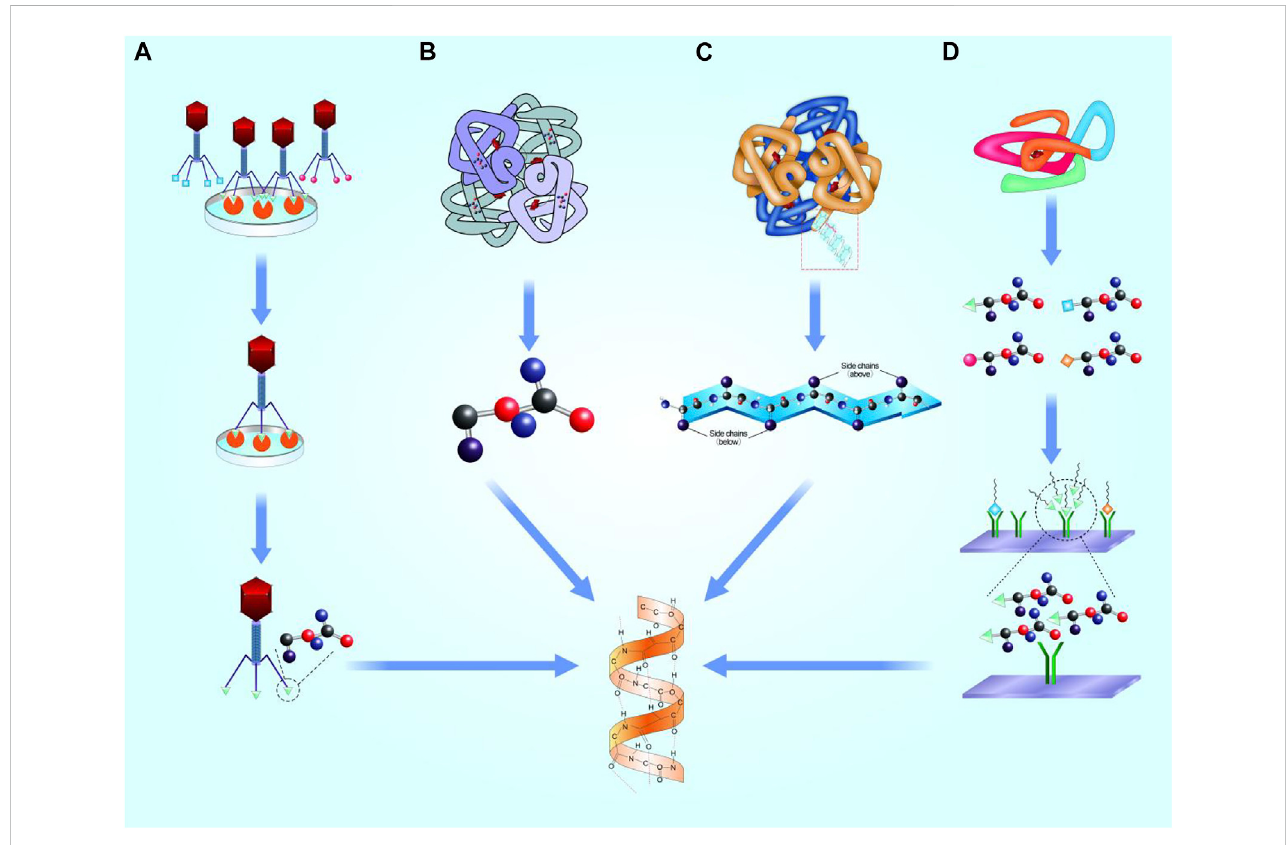
FIGURE 1 Selection mechanisms of functional motifs. (A) . Phage display technology. (B) . Highly repetitive conserved sequences. (C) . Microarray chip. (D) . Microstructure simulation of functional